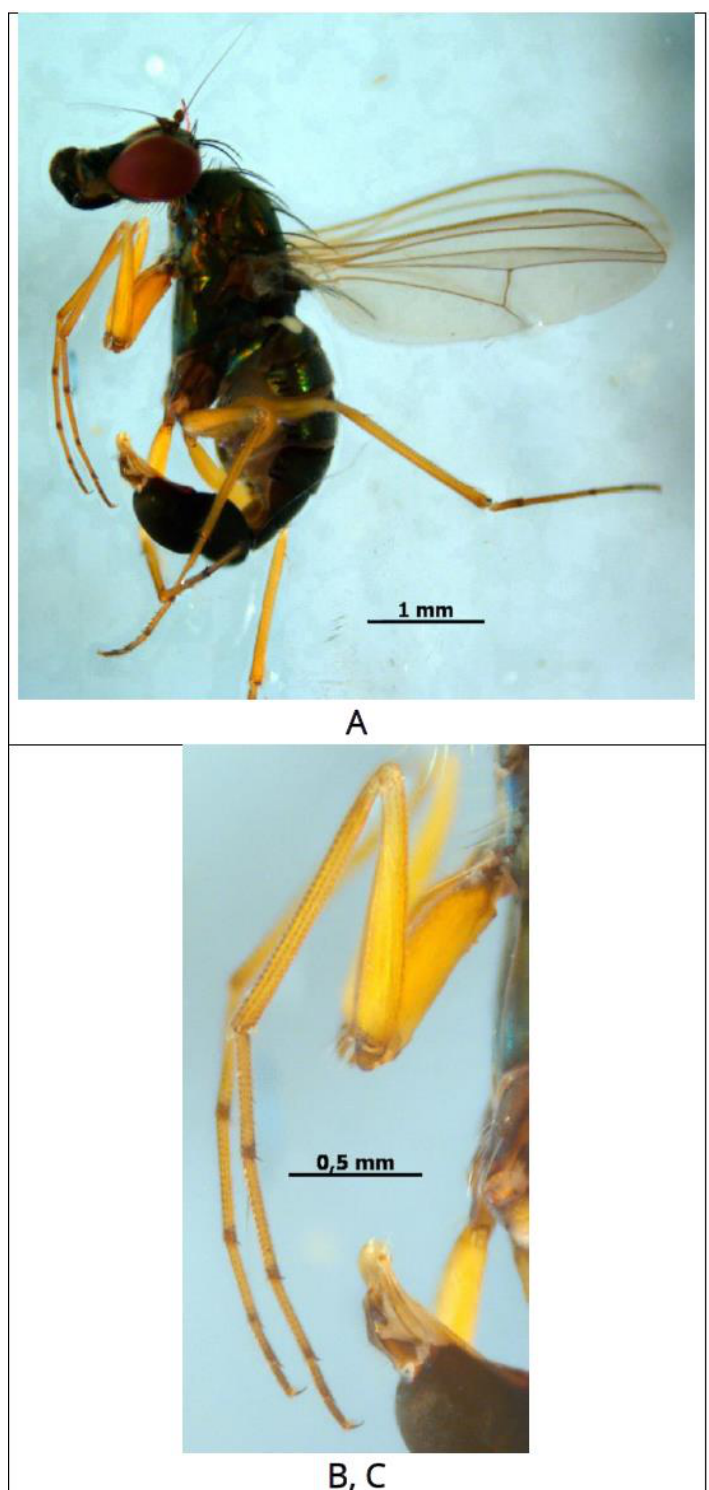
Fig. 2. Medetera media Parent, 1925: A-male habitus; B-fore leg; C-hypopygium. Thinophilus Wahlberg, 1844 Thinophilus